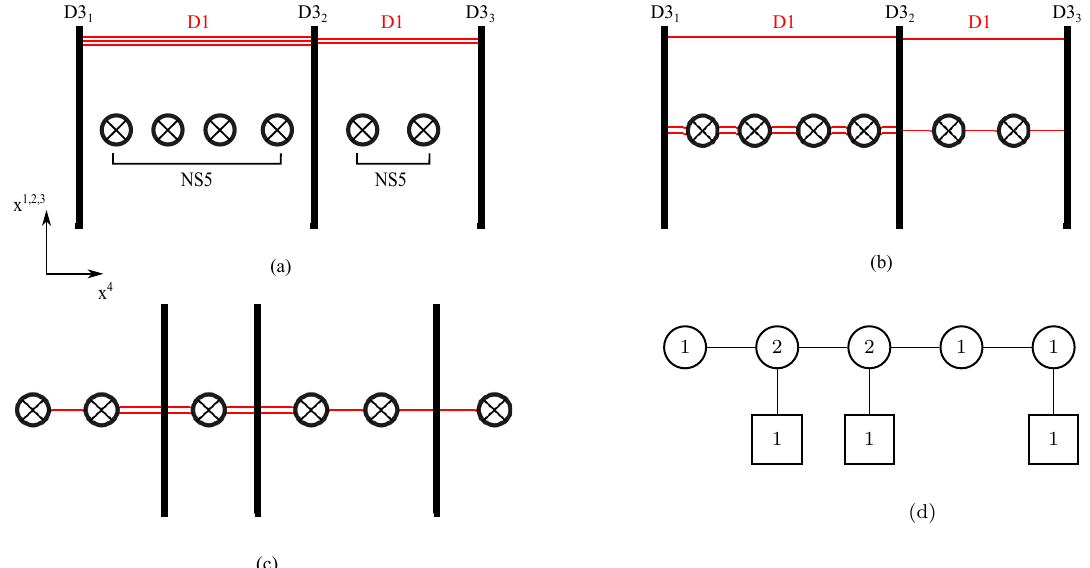
Figure 1 . This (cid:12)gure shows many facets of the brane con(cid:12)guration describing singular monopoles and monopole bubbling in 4D N = 2 SYM gauge theory for the example of SU(3) gauge theory with (cid:13) m = 3 H 1 +2 H 2 and P = 4 h 1 +2 h 2 (a). (b) displays an example of monopole bubbling